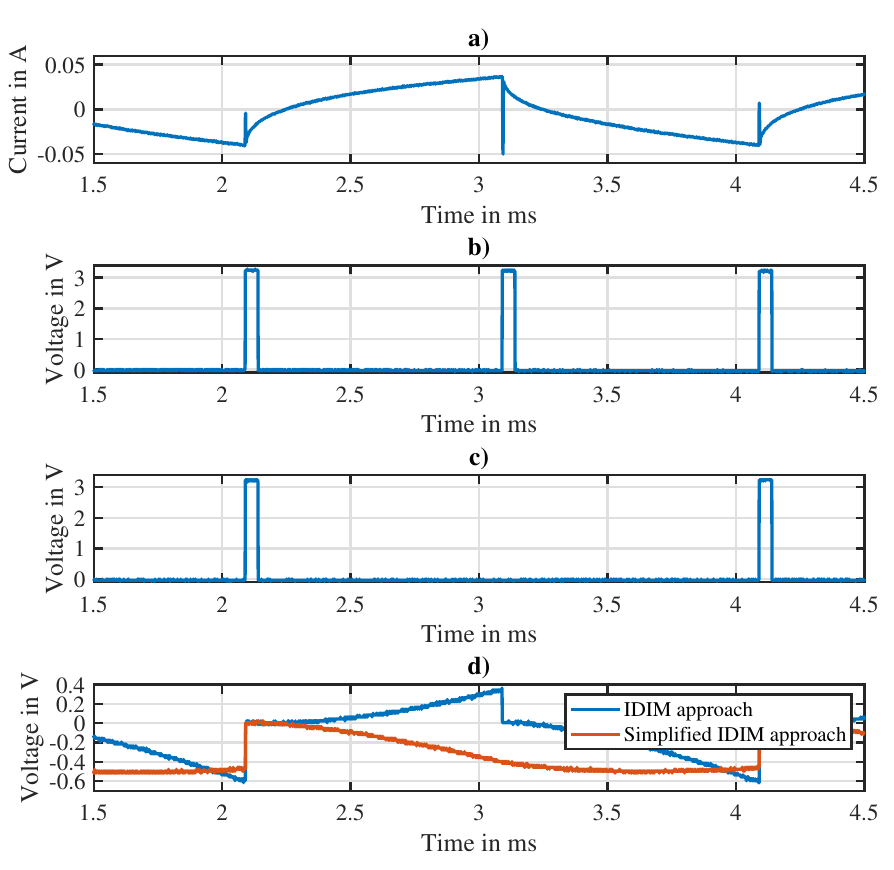
Figure 11. Measurements of the analog signals of the IDIM circuitry, ( a ) sensed current signal, ( b ) trigger signal r ( t ) in case of the IDIM approach, ( c ) trigger signal r ( t ) in case of the simplified IDIM approach, ( d ) resulting output of the integrator circuit in case of the IDIM approach (blue) and the simplified IDIM approach